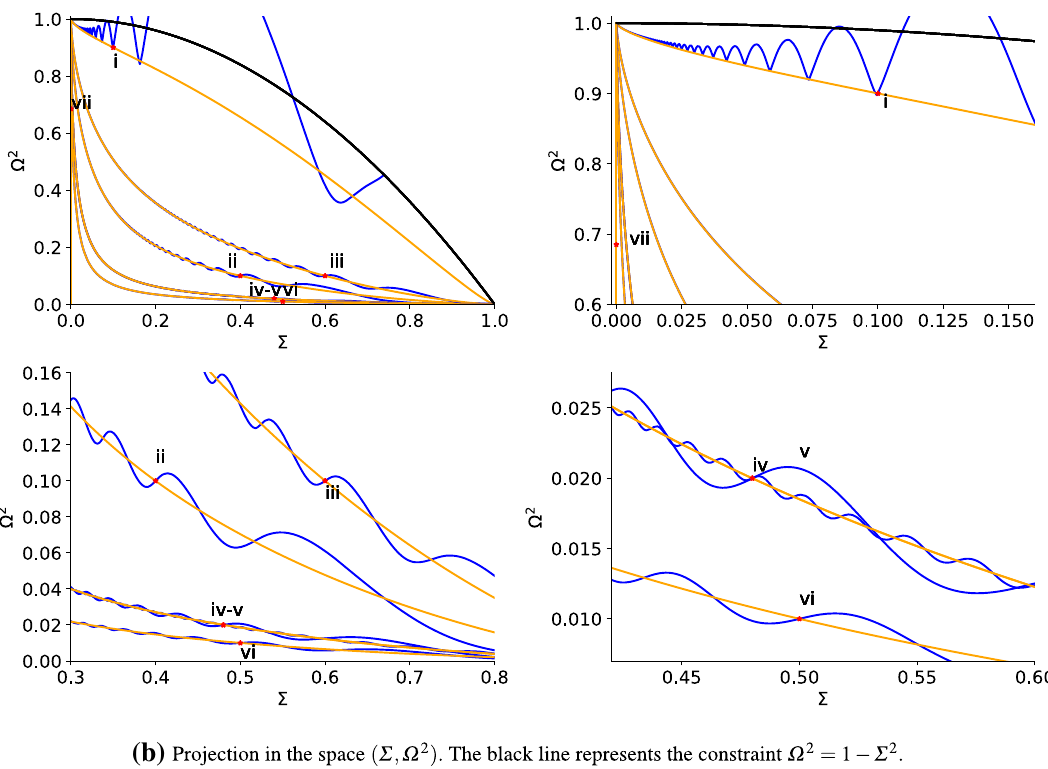
Fig. 5 Some solutions of the full system (44) (blue) and time-averaged system (72) (orange) for Bianchi I metric when γ = 4 / 3. We have used for both systems the initial data sets that are presented in Table